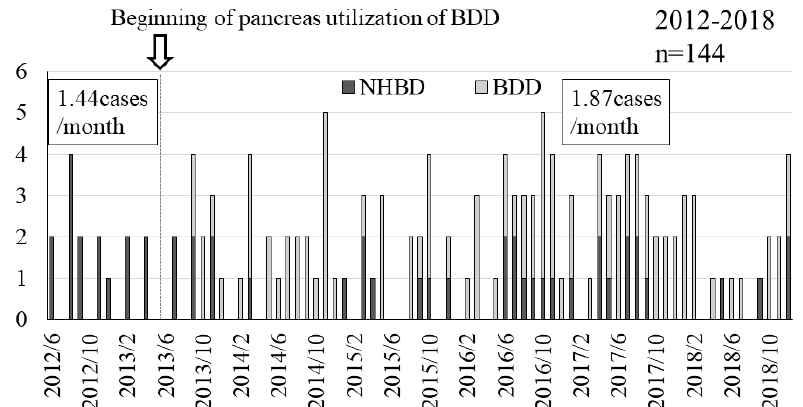
Figure 5. The number of islet donors whose information was given to the secretariat of islet transplants. From 2013 to the end of 2018, the number of donors whose information was given to the secretariat increased to 1.87 cases/month. In contrast, the number was 1.44/month in 2012, when only NHBDs were used; NHBDs, non-heart-beating donors; BDD, brain-dead donors.